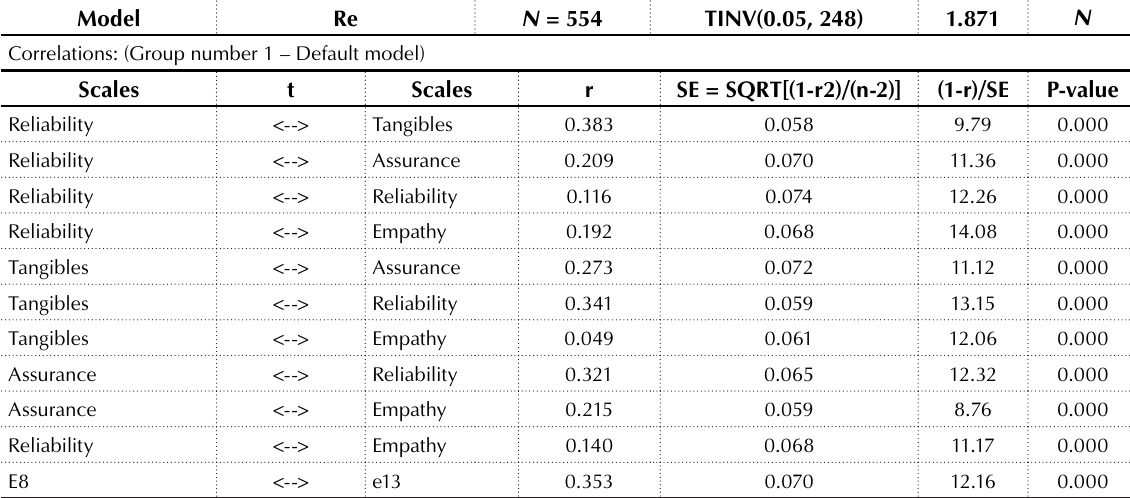
Source: The researcher’s collecting data and